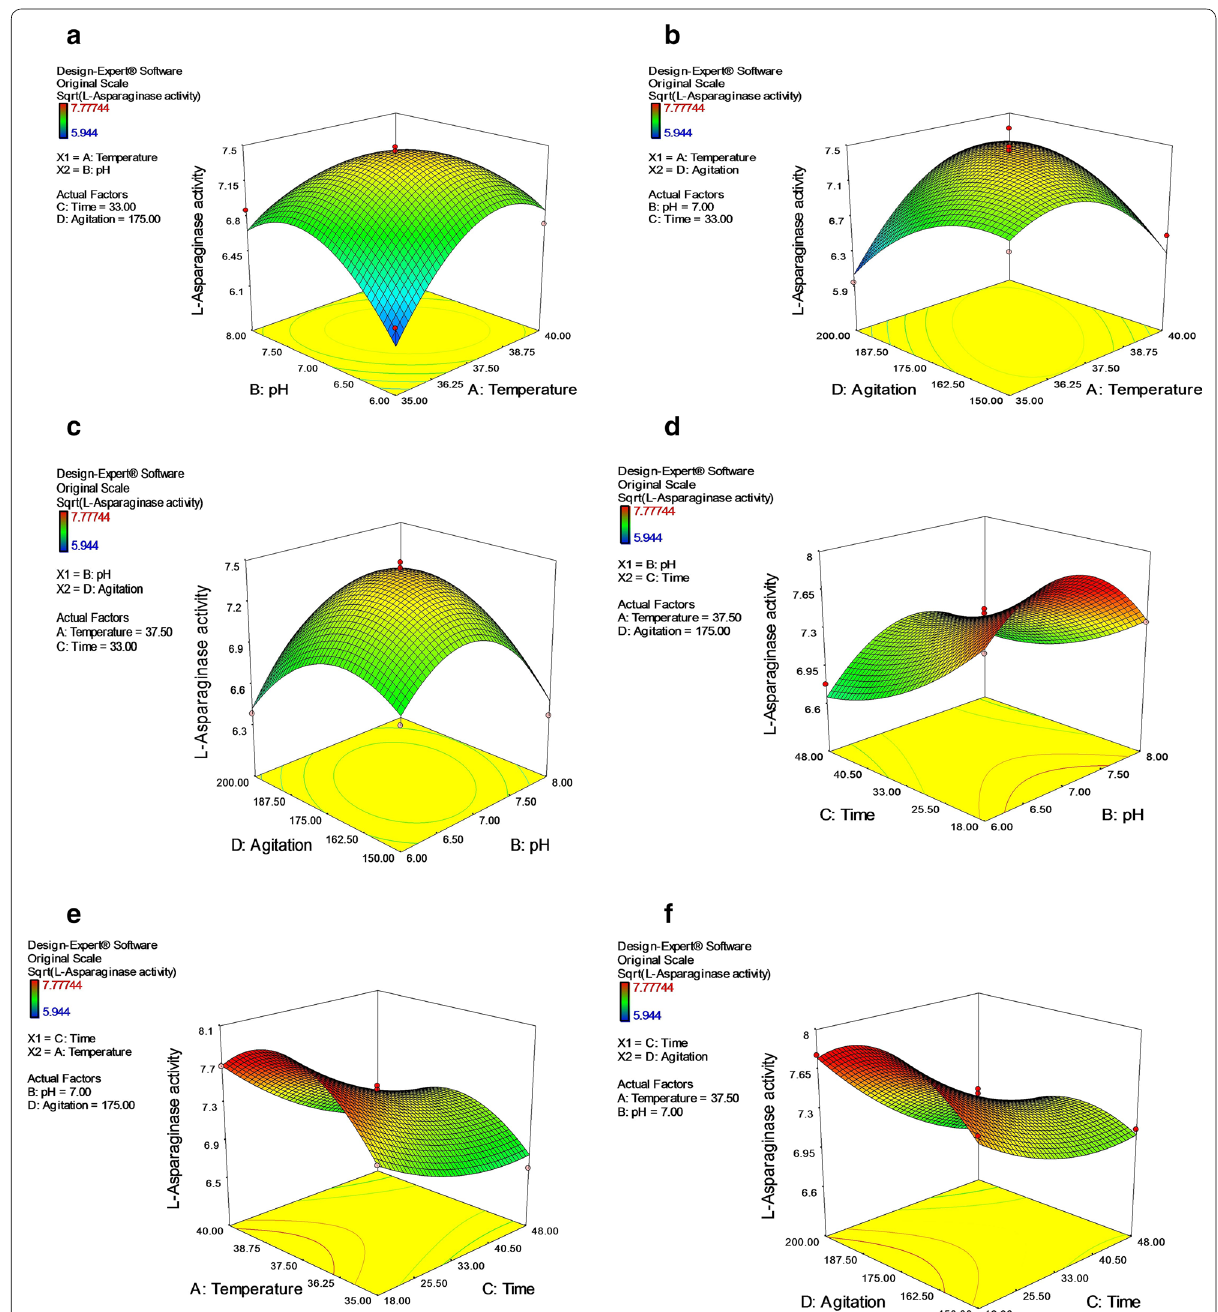
Fig. 5 Graphs showing process parameters optimization for l -asparaginase production by Stenotrophomonas maltophilia EMCC2297 variant as revealed by Response surface methodology analysis. The graphs show the interactions between: a temperature of incubation (°C) and pH; b temperature of incubation (°C) and rate of agitation (rpm); c pH and rate of agitation (rpm); d pH and incubation periods (h); e incubation periods (h) and temperature of incubation (°C); and f incubation periods (h) and rate of agitation